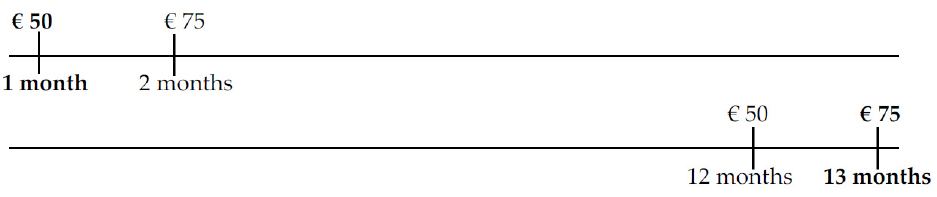
Figure 3. Delay e ff ect (Example 2). Source: Own